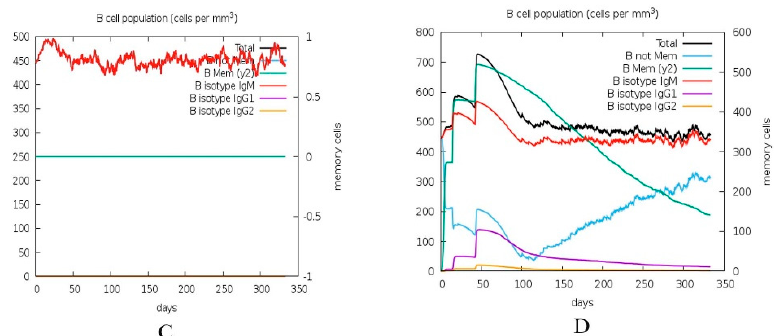
Figure 5. ( A ) Antigen and immunoglobulins of control, ( B ) antigen and immunoglobulins of construct C1 with antibodies sub-divided per isotype. ( C ). B lymphocytes showing total count, memory cells (isotypes IgM, IgG1, and IgG2) for control. ( D ). B lymphocytes showing total count, memory cells (isotypes IgM, IgG1, and IgG2) for construct C1.